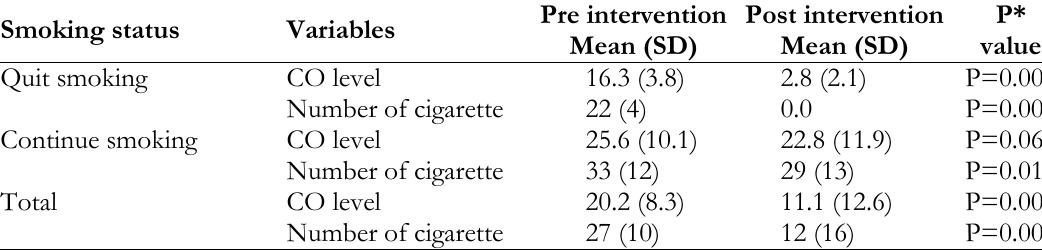
Table II. The outcomes of nicotine patch therapy (n = 31) Smoking status